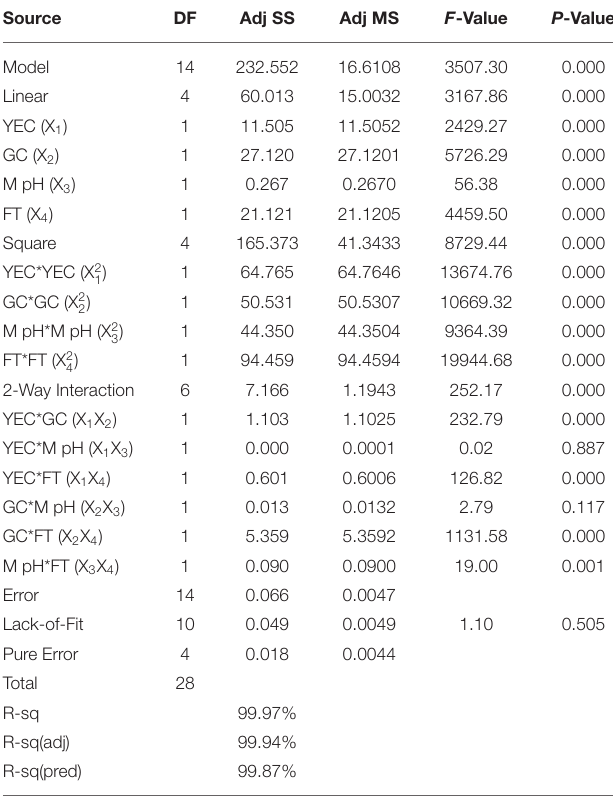
TABLE 5 | ANOVA for response surface quadratic regression model of exopolysaccharide yield of Colletotrichum alatae